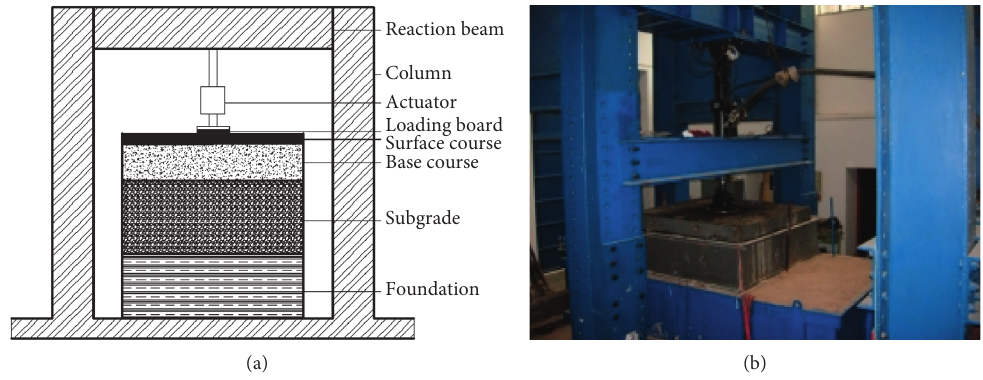
Figure 2: MTS load system. (a) Load device model diagram. (b) Actual drawing of the loading